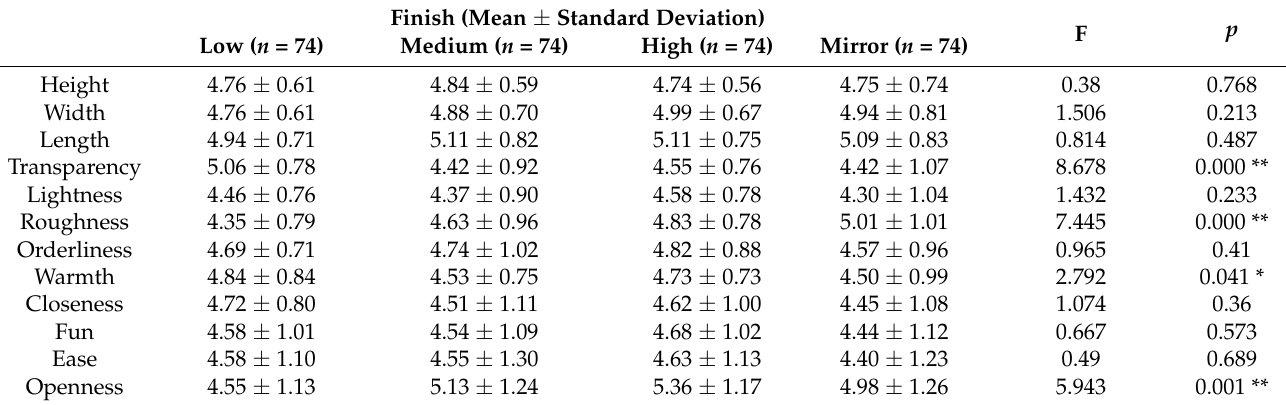
Table 12. Variance Analysis of finish classification.